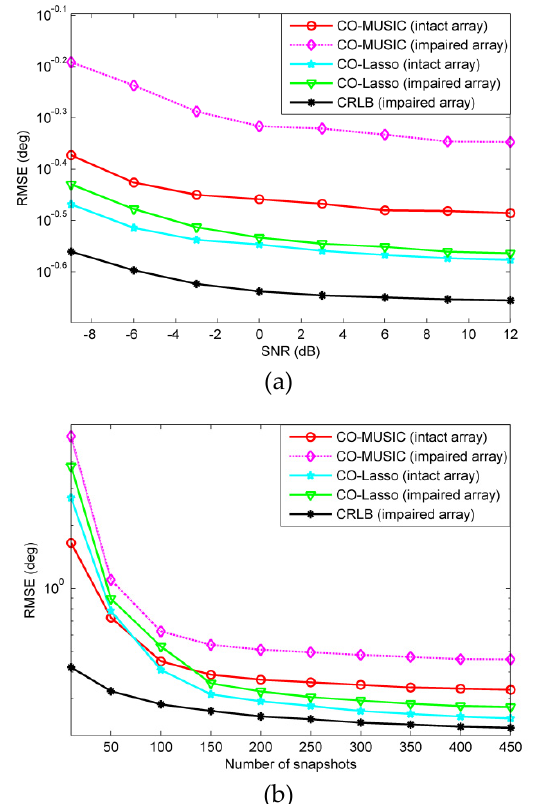
Figure 6. The scenario of redundant sensor failures, the root mean square error (RMSE) performance comparison of CO-MUSIC and CO-Lasso with 500 Monte Carlo trials and 18 sources considered. ( a ) RMSE versus SNR with L = 300 and ( b ) RMSE versus the number of snapshots with SNR = 0 dB. For non-redundant sensor failures, take the { 5 d , 20 d , 24 d } position sensors failure in Figure 3 as